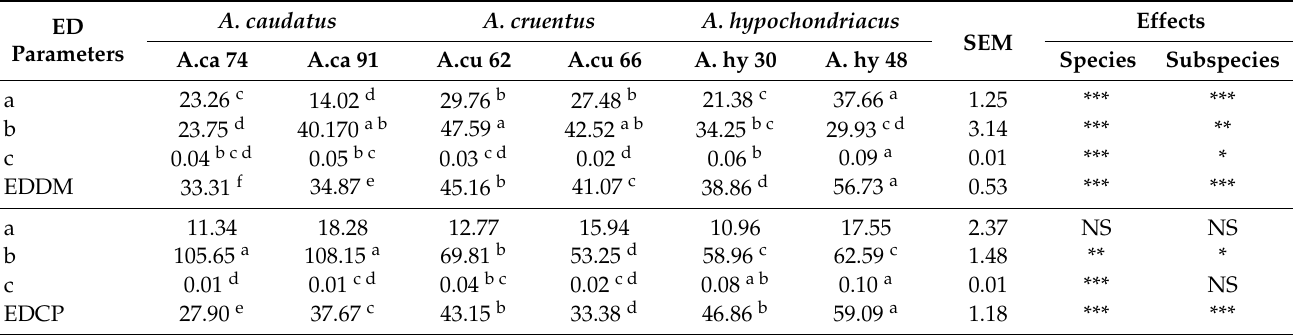
Table 4. Effective degradability of dry matter and crude protein and degradation parameters (a, b, c) of amaranth forages incubated in